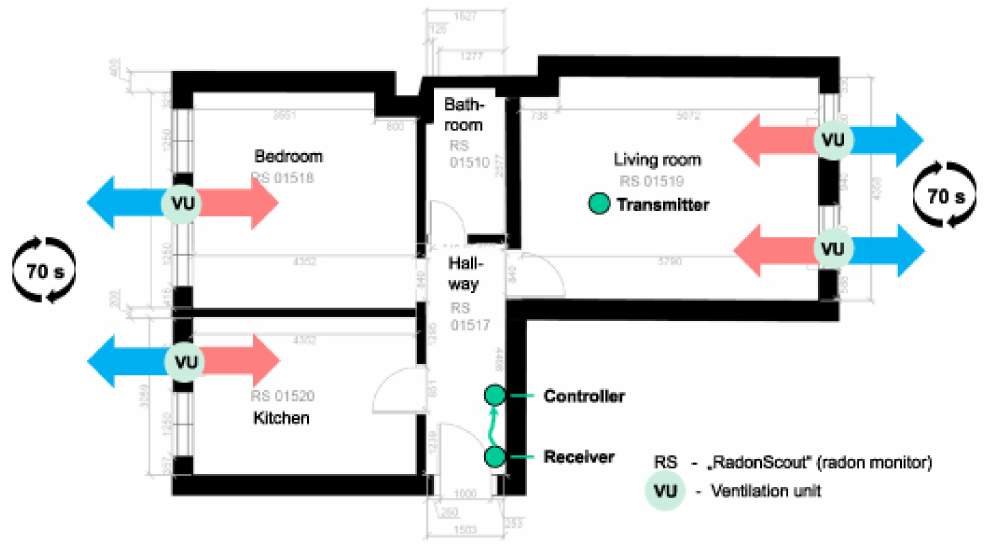
Figure 8. Decentralized ventilation system for an apartment analyzed in